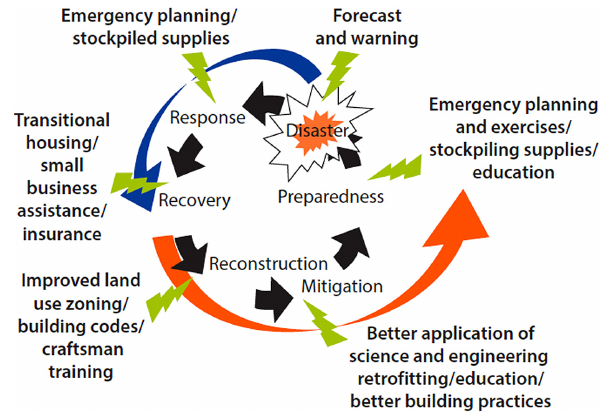
Figure 2. The phases of the disaster risk cycle (Jha et al.,